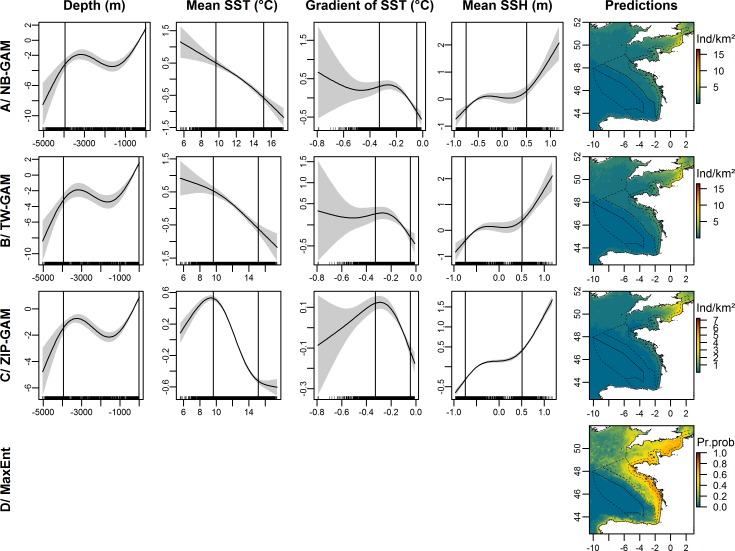
Estimated smooth functions for the selected covariates and predicted distribution of auks in individuals.km-2 (Ind/km2) for each presence-absence model and in presence probabilities (Pr.prob) for the Maxent model.The solid line in each plot is the estimated smooth function, and the shaded regions represent the approximate 95% confidence intervals. The y-axis indicates the number of individuals on a log scale, and a zero indicates no effect of the covariate. The best model fits are between the vertical lines indicating the 10th and 90th quantiles of the data. The dotted lines represent the bathymetric strata of the survey area.